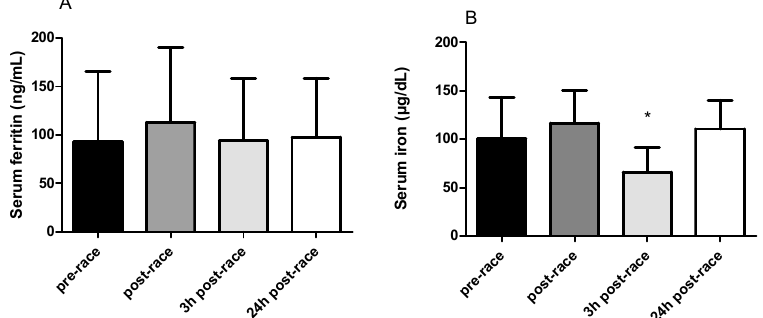
Figure 1. Serum ferritin ( A ) and iron ( B ) concentrations at different time points in the 24 participants. Values are presented as mean ± SD. * p < 0.05 compared to the pre-race value. 3.3. Effect of Exercise on mRNA Levels of Selected Genes Out of six genes tested, five were down-regulated at the end of the race compared with baseline, with the differences for PCBP1, PCBP2, FTH and CAT achieving statistical significance ( p = 0.0359, p = 0.0443, p = 0.0158 and p = 0.0182, respectively) (Figure 2). There was a trend for up-regulation in PCBP1 and PCBP2 ( p = 0.0826 and p = 0.2435, respectively) , and a significant up-regulation in FTH and FTL genes ( p = 0.0056 and p = 0.0064, respectively) at 3 h after the marathon run. The mRNA levels of all genes except for TFRC, which remained insignificantly decreased ,